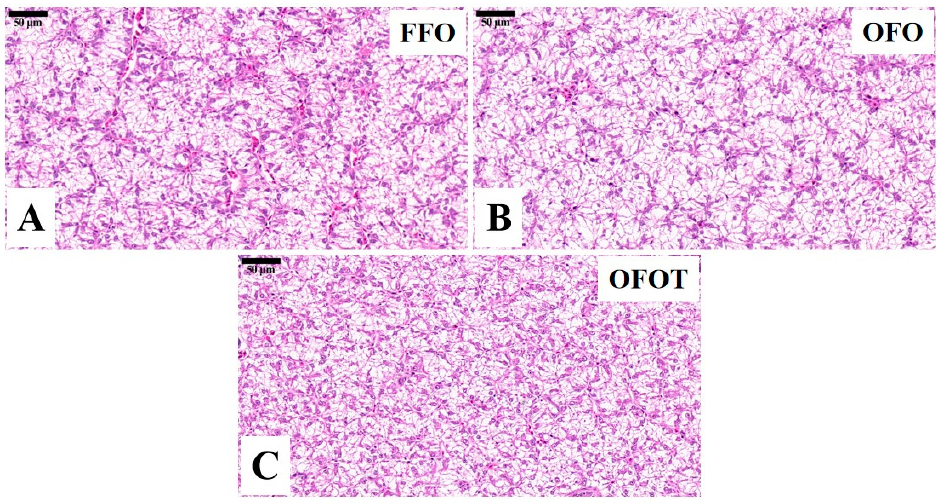
Figure 2. Histological characteristics of the liver in channel catfish ( Ictalurus punctatus ) fed the diets (H&E stain, magnification 400×). ( A ) Fresh fish oil (FFO) group; ( B ) oxidized fish oil (OFO) group; and ( C ) OFO diet with 0.2% taurine (OFOT) group. Table 5. Effects of dietary taurine on the morphometrics of the liver of channel catfish ( Ictalurus punctatus ) fed oxidized-fish-oil diets.